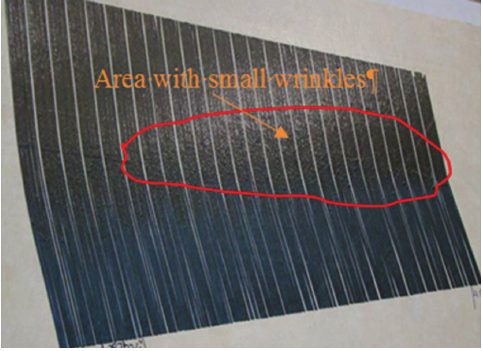
Figure 10 Fiber steering trial case 2: θ = 10 ° , ply 1, laid down at 10.7 m/min.